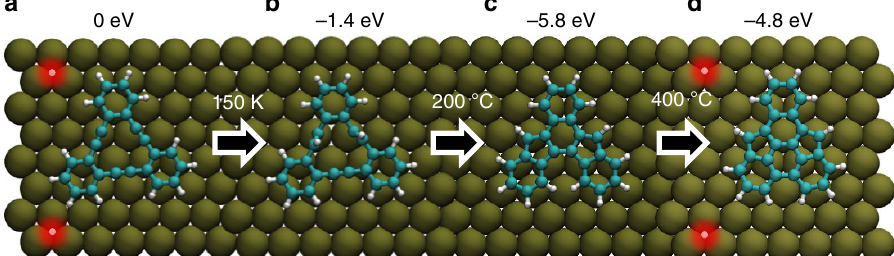
Figure 5 | Summary of the transformation process. The transformation proceeds from left to right (indicated by arrows). The reaction temperature for each transformation is shown. ( a ) Intact tDBA, which was not seen on Cu(111). ( b ) First product formed as deposited on a cold Cu(111). ( c ) Second product after annealing at 200 (cid:2) C. ( d ) Third product after annealing at 400 (cid:2) C. In the two middle structures the molecule contains 14 hydrogen atoms; in the first and last configurations these extra hydrogen atoms are placed on the copper surface (highlighted in